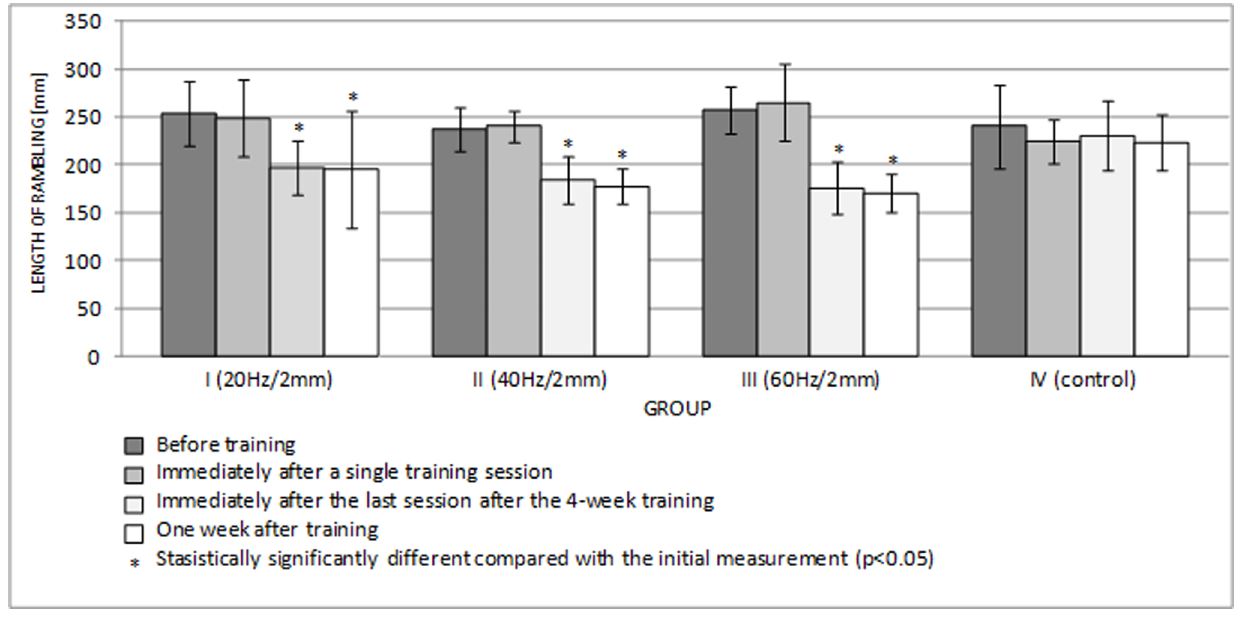
Figure 6. Length of rambling in the AP plane (mean ± standard deviation) (mm) after training.